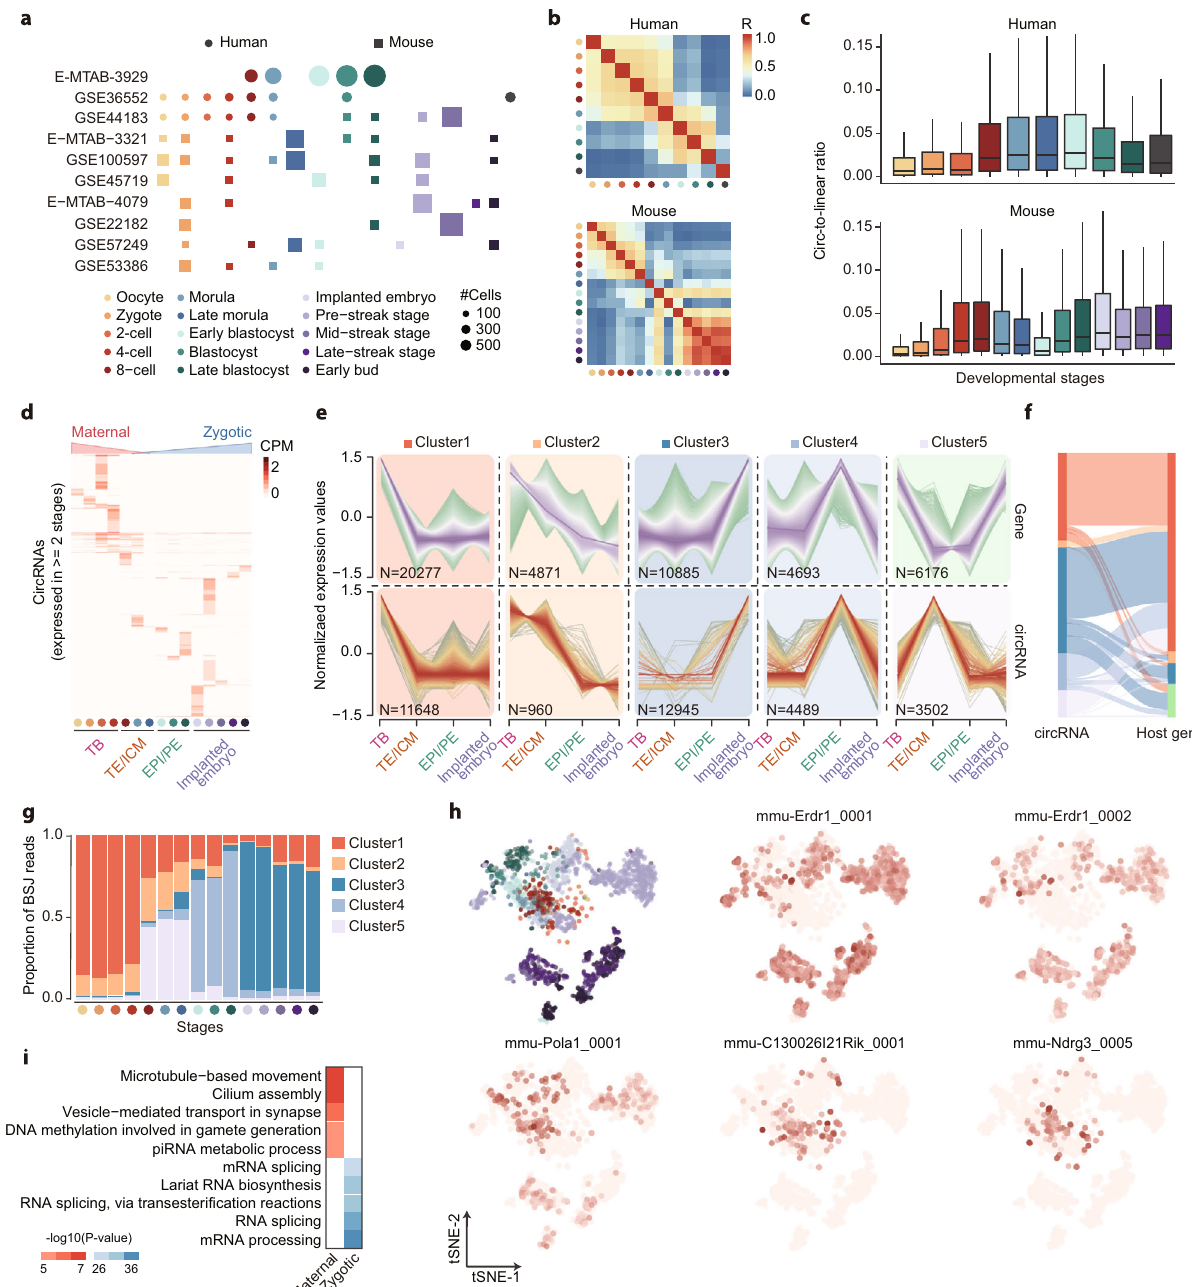
Fig. 3 Dissection of zygotic circRNA activation during the maternal-to-zygotic transition. a Summary of scRNA-seq datasets on different embryo developing stages of human and mouse. The size of points indicates the number of cells in each developing stage. b Correlation of circRNAs expression in human and mouse embryo developing stages. Filled colors represent the Pearson correlation coef fi cient between average expression levels of circRNAs in each stage. c Boxplot illustrating the circular-to-linear ratio of circRNAs in each stage of human ( n = 5876/ 11,908 / 13,561 / 18,634 / 16,379 / 22,717 / 4,090 / 9,160 / 2,573 / 2,784 circRNAs) and mouse ( n = 1928 / 2579 / 10,998 / 6789 / 3174 / 3262 / 62 / 1142 / 1306 / 2279 / 2997 / 7300 / 805 / 1079 / 1300 circRNAs) embryos. The y axis represents the circular-to-linear ratio measured as the expression level of circRNAs divided by the host gene expression values. The center lines indicate the median values, and box limits indicate the upper and lower quartiles of plotted values. The upper and lower whiskers indicate the largest and smallest values within the range of 1.5-fold IQR from the box limits. d Heatmap of circRNAs (expressed in (cid:1) 2 stages) expression. Filled colors represent the average CPM of circRNAs in each stage, and all stages were divided into four time points according to the cell differentiation and lineage segregation state. e Fuzzy clustering of circRNAs expression data in four time points. Purple or red colored lines correspond to genes with high membership value, and y axis represents the normalized expression value from the Mfuzz result. f The consistency of cluster results of circRNAs and host genes. Filled colors indicate the clustered results. g Composition of maternal (cluster 1 – 2) and zygotic (cluster 3 – 5) circRNAs in each stage. h The t-SNE projection of all cells and typical maternal (bottom) and zygotic (upper) circRNAs, colored by indicated developing stages points or expression level of circRNAs. i Gene ontology enrichment for the maternal and zygotic circRNAs. Colors indicate q-value computed using two-sided Fisher exact test and adjusted using Benjamini-Hochberg method for multiple hypotheses testing. Source data are provided as a Source Data fi